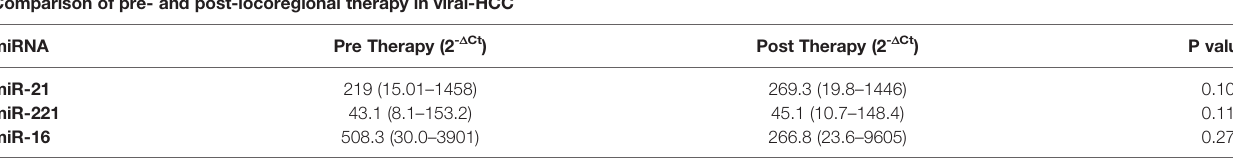
TABLE 3B | Comparison of oncomiRs expression before and after LRT in all viral HCC patients. Comparison of pre- and post-locoregional therapy in